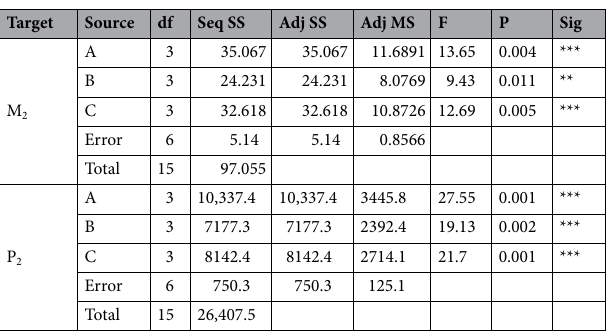
Table 3. Analysis of variance. *Relatively significant (P < 0.10); **significant (P < 0.05); and ***extremely significant (P <